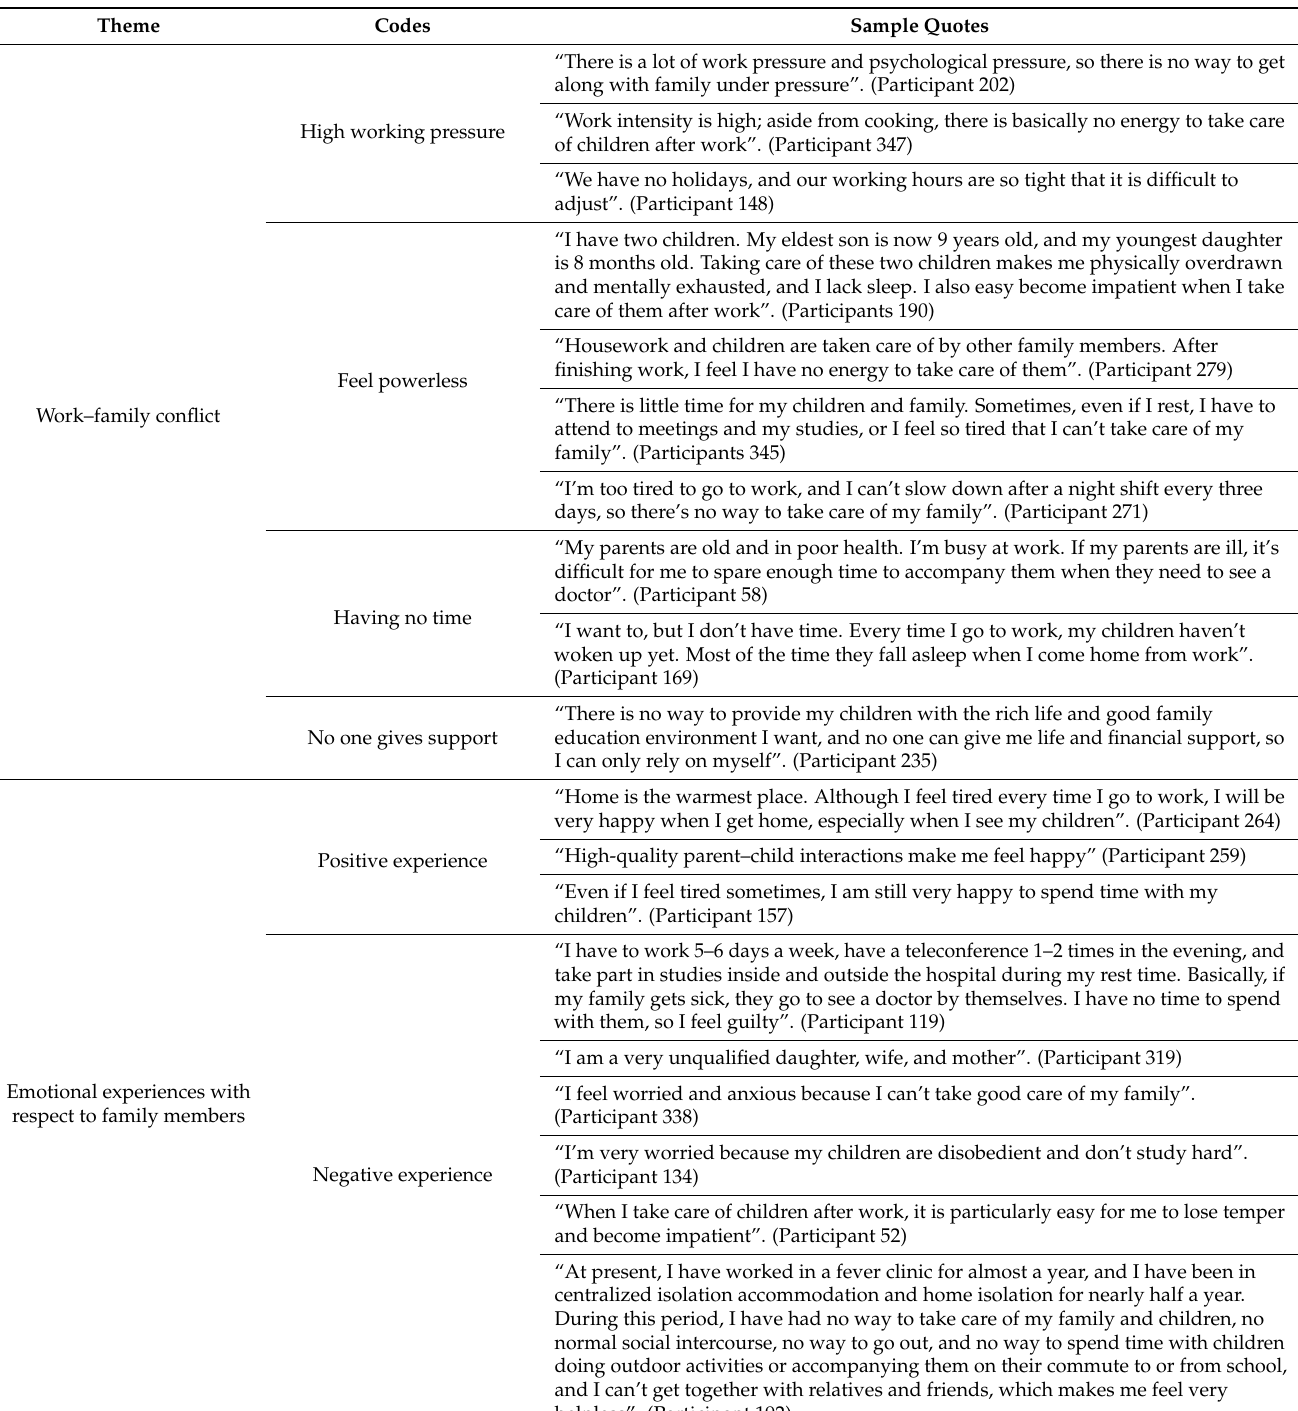
Table 6. List of themes and subthemes of the open-ended survey